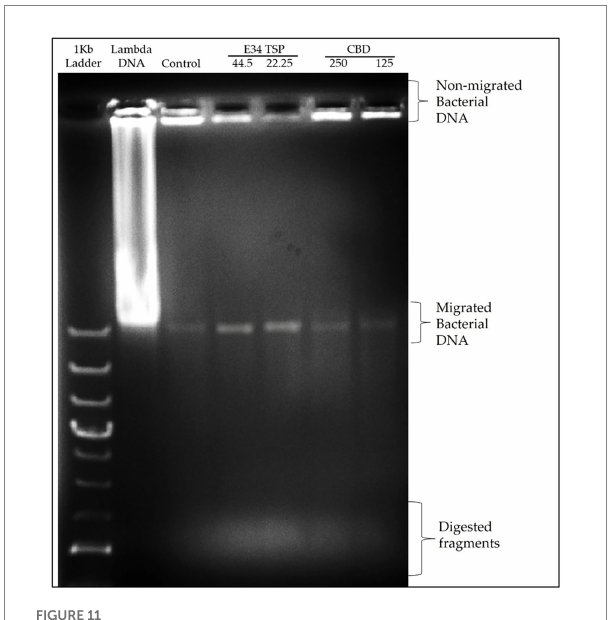
FIGURE 11 Agarose gel analysis of S . Typhimurium treated to CBD extract, or E34